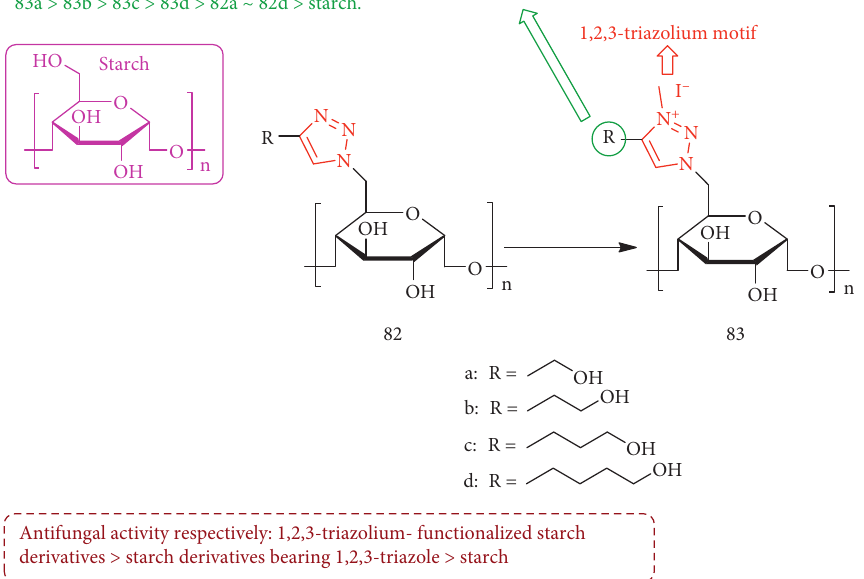
Figure 33: Chemical structure of novel 1,2,3-triazolium-functionalized starch